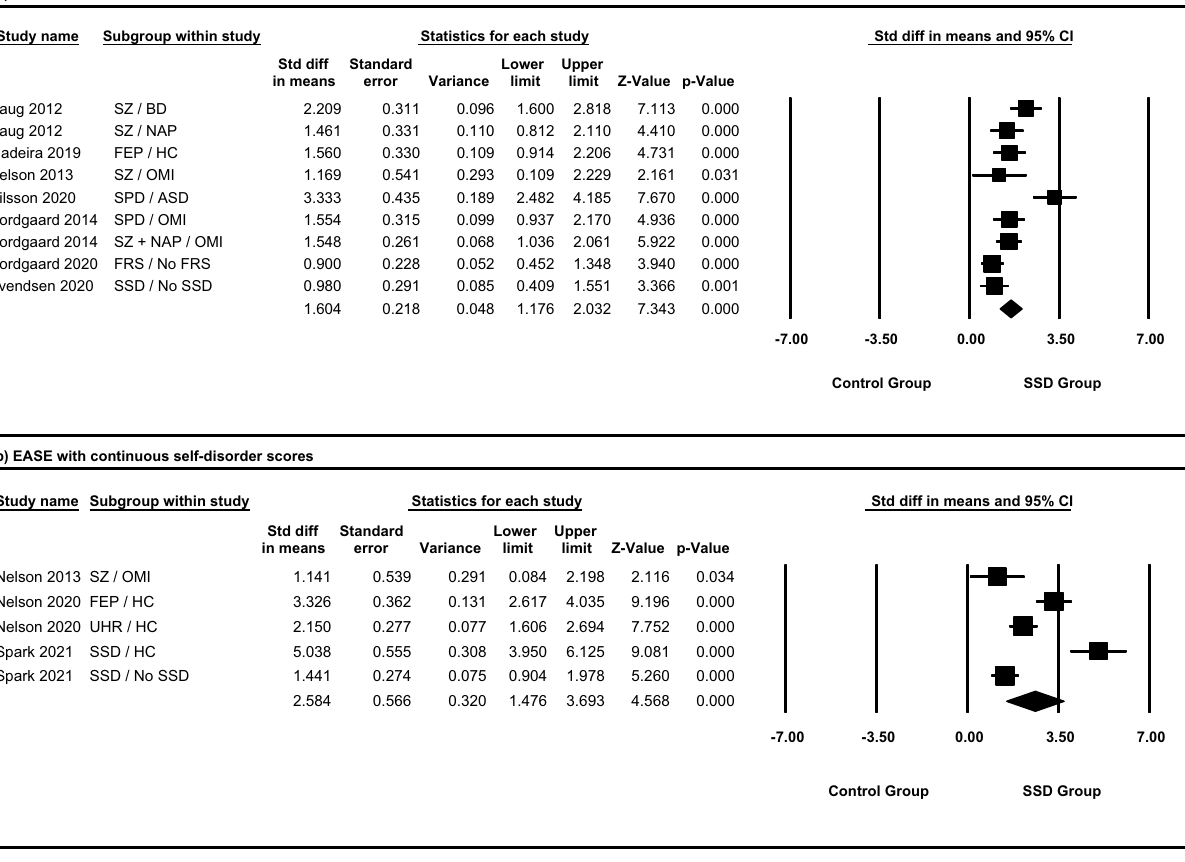
Figure 3. Meta-analysis of the aggregation of self-disorders in schizophrenia spectrum and control groups, as measured with the examination of anomalous self-experiences (EASE). Studies are grouped by the type of self-disorder score reported. ( a ) Describes the standard difference in means for dichotomous total self-disorder scores in schizophrenia spectrum and control groups. ( b ) Describes the standard difference in means for continuous total self-disorder scores in schizophrenia spectrum and control groups. Diamonds indicate pooled effect sizes and squares indicate individual study effect sizes. Data shown as mean ± SEM of self-disorder scores and are representative of two independent samples; values are significant if p < 0.05. ASD = autism spectrum disorder, BD = bipolar disorder, FEP = first episode psychosis, FRS = first rank symptoms, HC = healthy control, NAP = non-affective psychosis, OMI = other mental illness, SD = self-disorder, SPD = schizotypal personality disorder, SSD = schizophrenia spectrum disorder, SZ = schizophrenia, UHR = ultra-high risk for